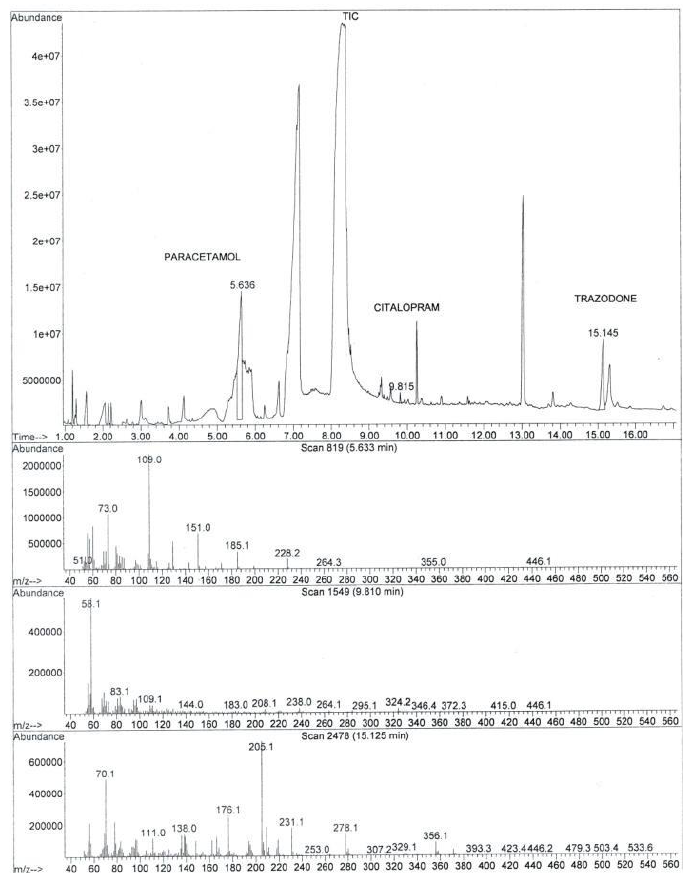
Figure 3. Full scan mode chromatogram and mass spectra obtained from peripheral blood analysis .